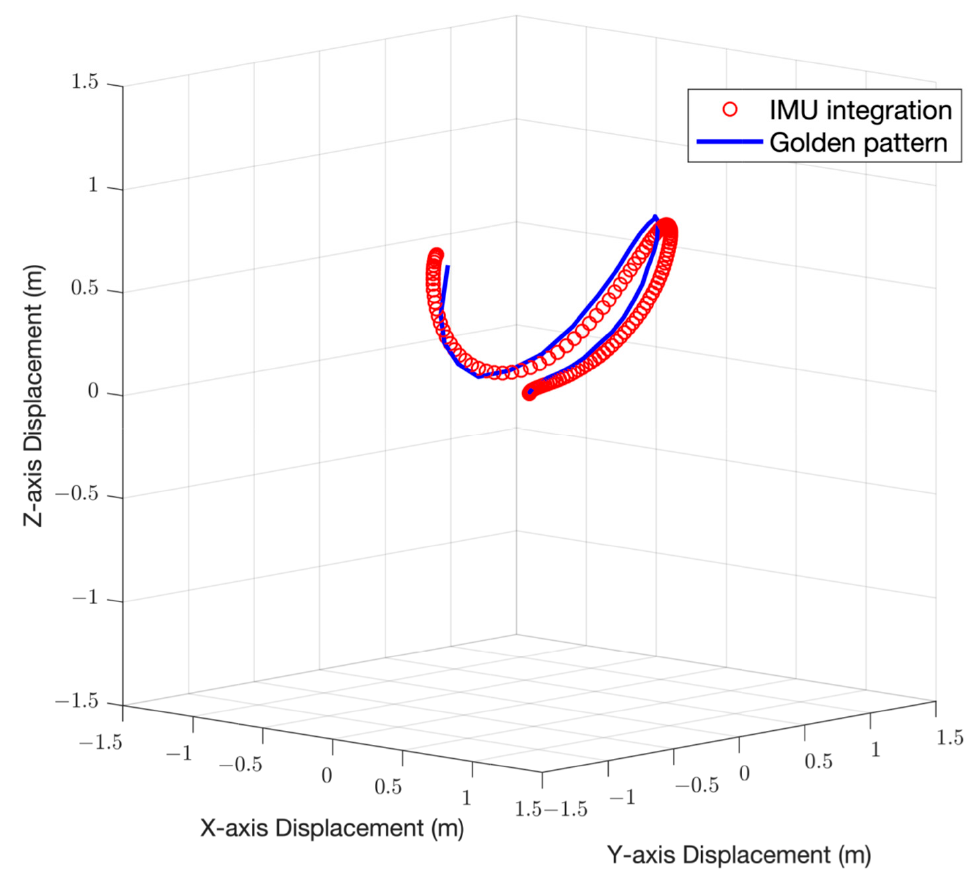
Figure 3. Three-dimensional motion trajectory diagram. For an instep kicking motion of path length around 3.63 m, the position RMSE and the velocity RMSE of the two trajectories are 0.07 m and 0.034 m/s, respectively.